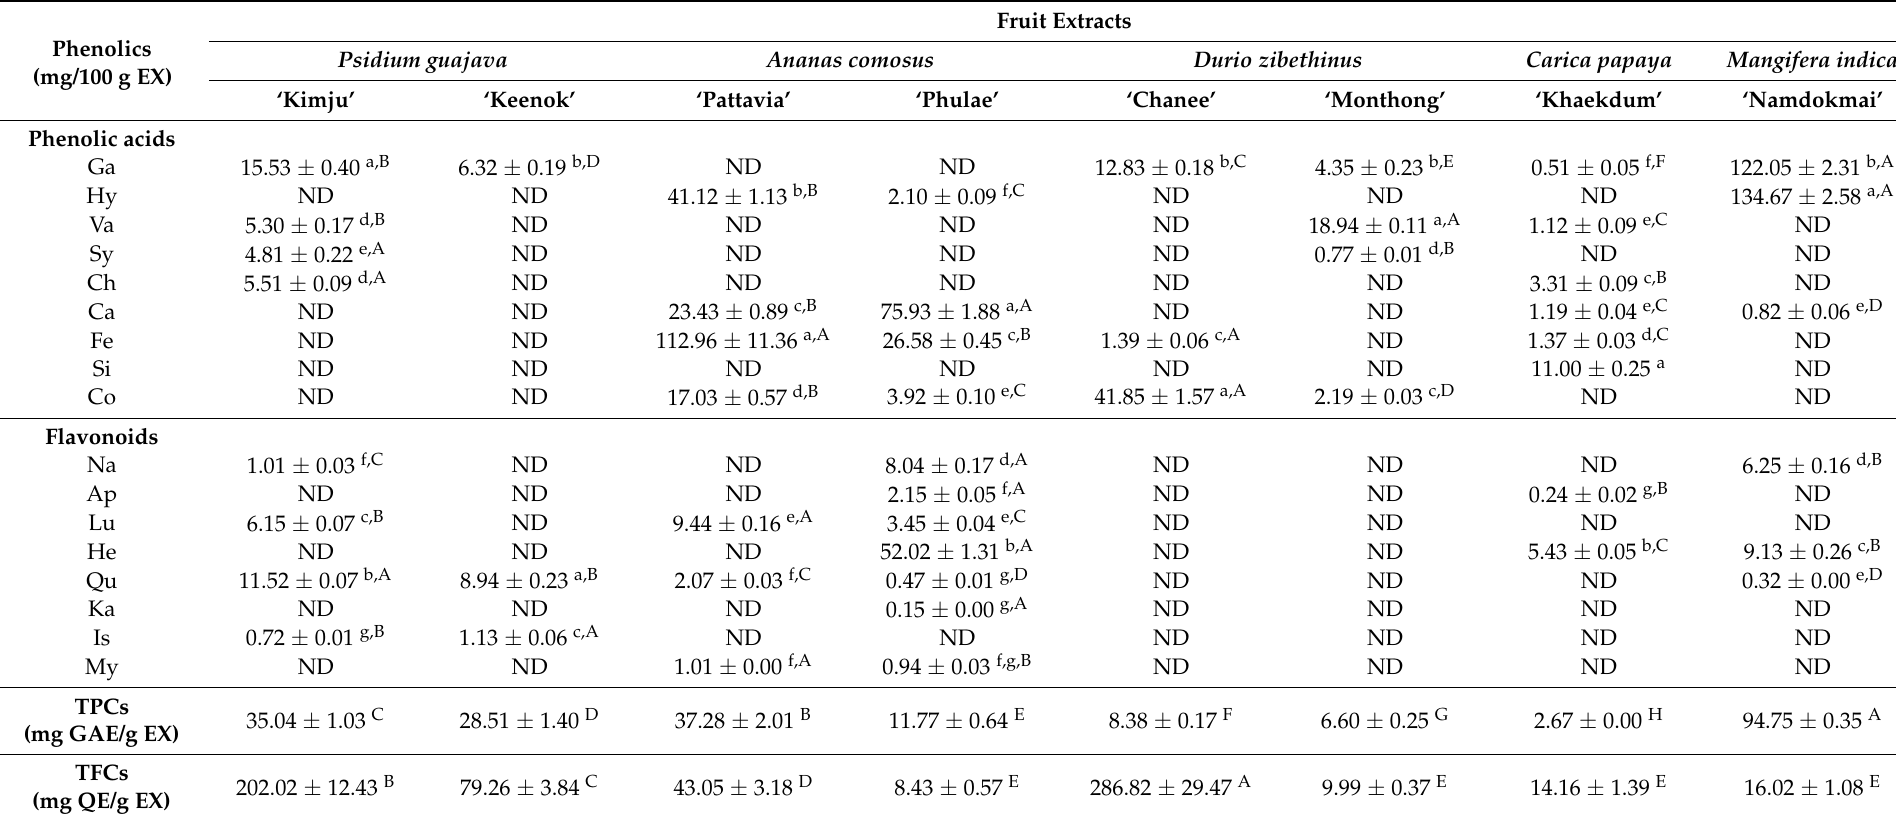
Table 1. Phenolic profiles, total phenolic contents (TPCs), and total flavonoid contents (TFCs) of the fruit